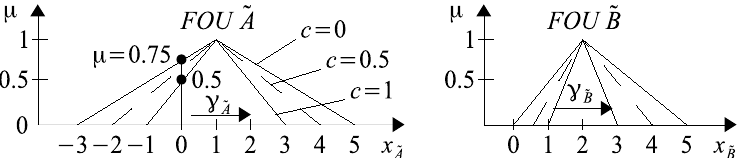
Figure 28. Footprints of uncertainty FOU ˜ A and FOU ˜ B of T2FNs ˜ A and ˜ B , the number ˜ A contains zero. Points µ = 0.75 and µ = 0.5 correspond to x ˜